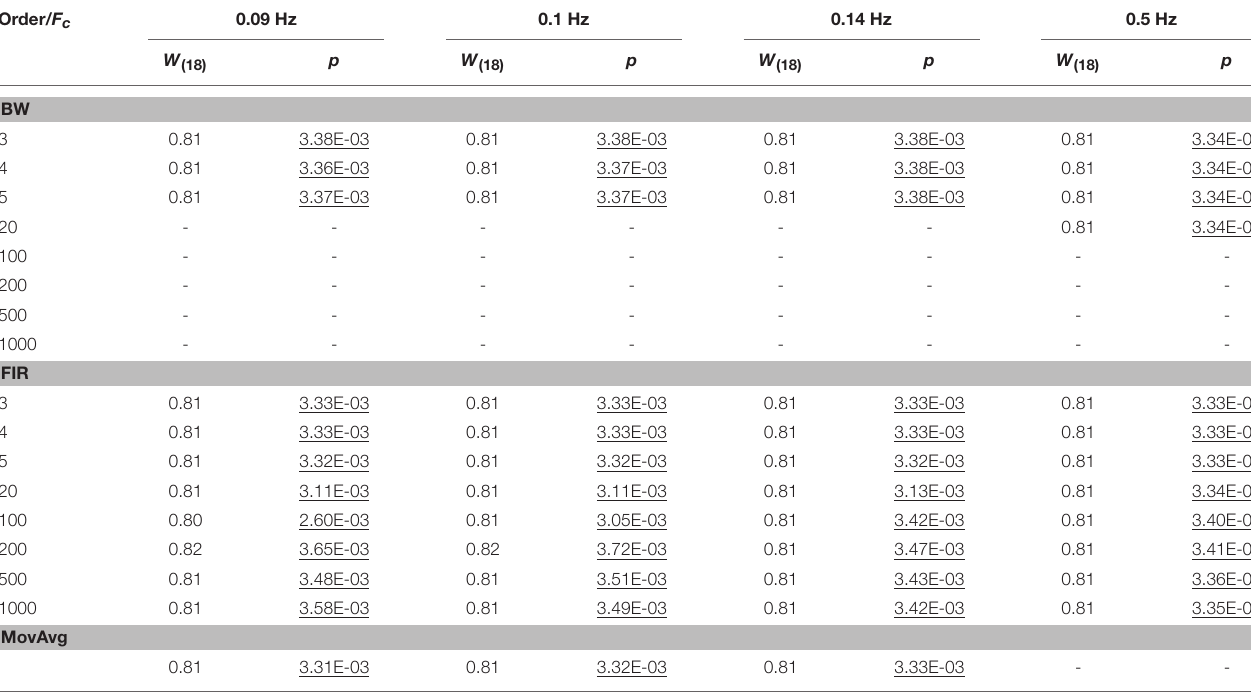
W-values and corresponding p-values are reported. p < 0.05 are underlined, meaning that the null hypothesis that the β -values are normally distributed is rejected at significance level α = 0.05. Results are not reported in case of unstable filters and F c = 0.5Hz that corresponds to a null window length for the MovAvg filter. ‘-’ indicates unstable filters for which the Shapiro-Wilk test was not carried